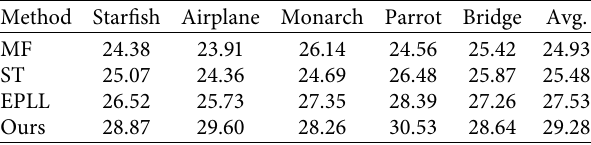
Table 1: Experimental results with less Gaussian noise (PSNR/dB). Method Starfish Airplane Monarch Parrot Bridge Avg.